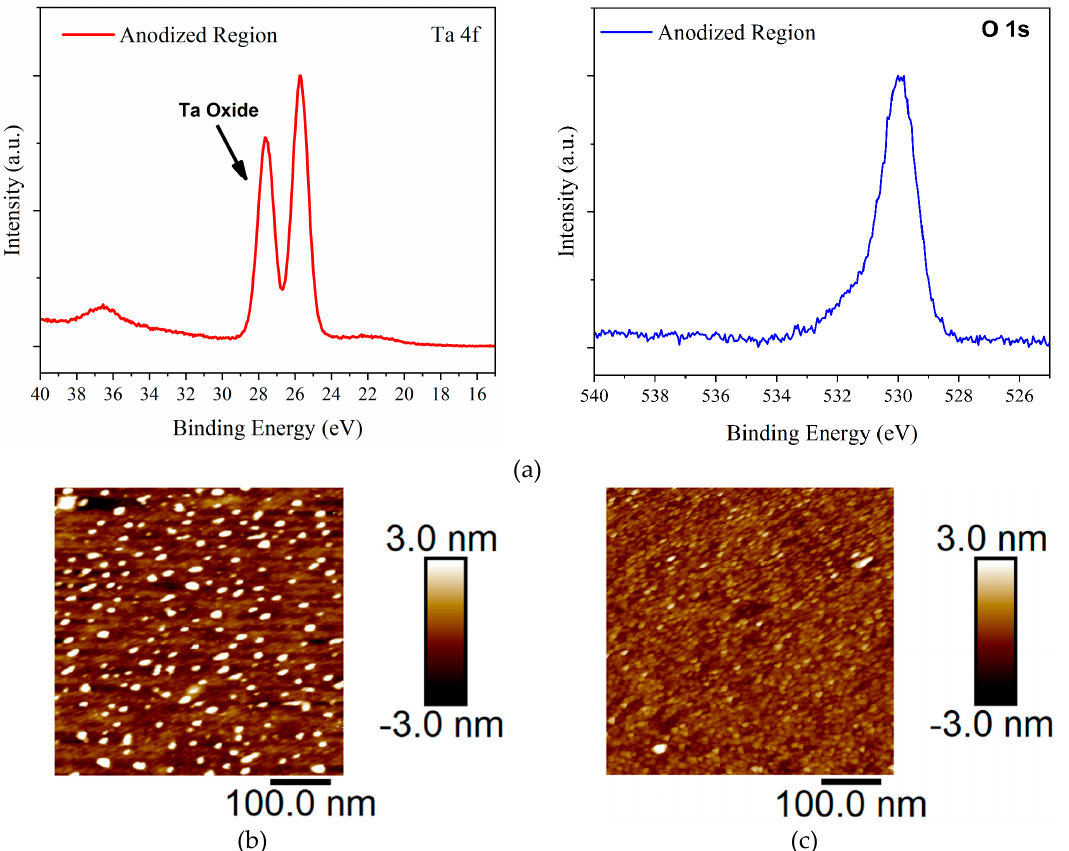
Figure 2. ( a ) Ta 4f and O 1s XPS spectra of the fabricated Ta 2 O 5 films. ( b ) AFM topography image of untreated Ta 2 O 5 and ( c ) OTS-treated Ta 2 O 5 films, respectively.